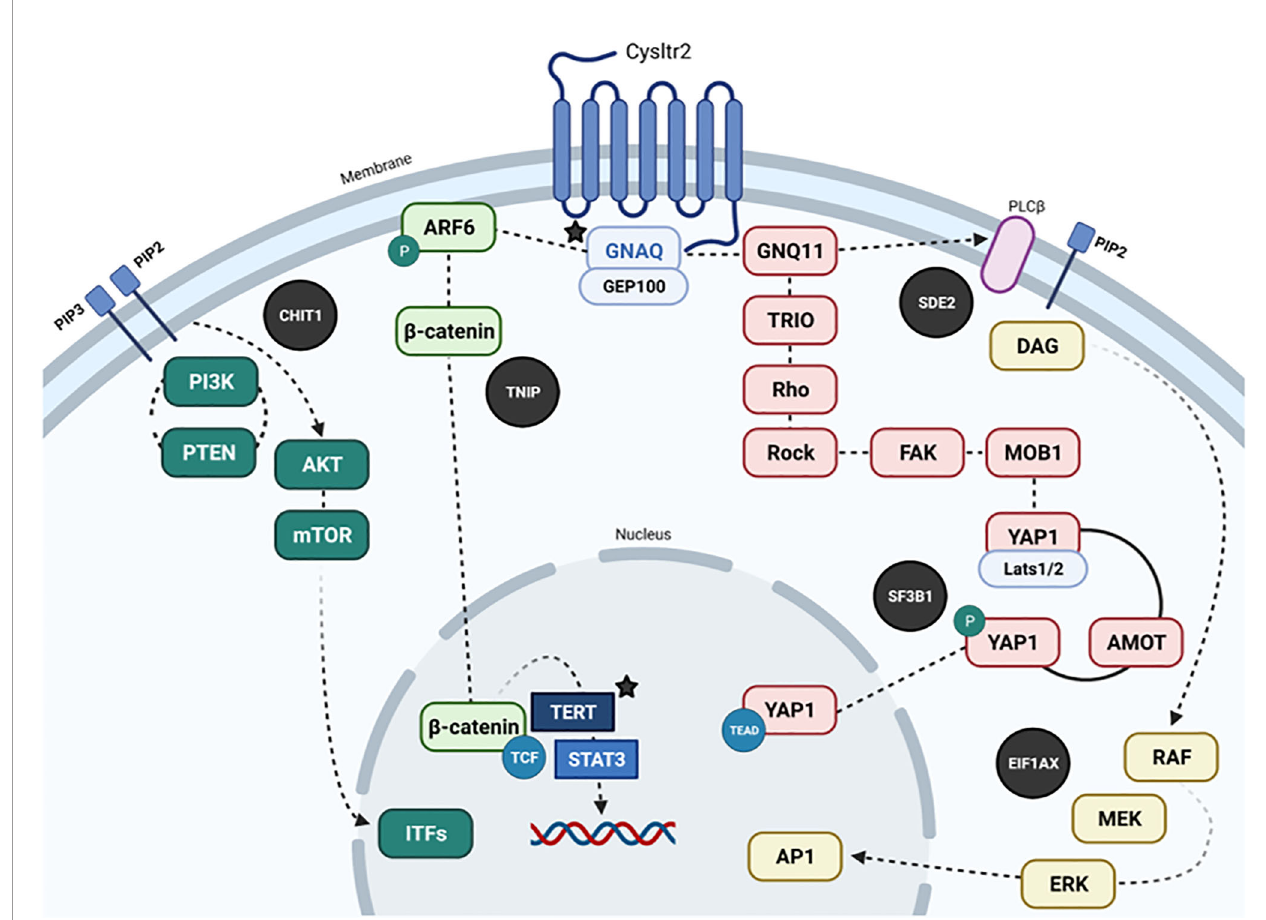
FIGURE 7 | Dysregulated pathways in PMMs (in black circles, other mutated genes are highlighted with their protein representation, and colocalization parallel to the main signaling pathways). Recurrent mutations in GNAQ, PLC b 4, and CYSLTR2 are mutually exclusive and trigger G a q signaling and related pathways (Akt/mTOR, Wnt/ b -catenin, Yes-associated protein (YAP), and MAPK pathways). In brief, GNAQ mediates signals between the G protein-coupled receptor (GPCR) and downstream effectors. Receptor activation by ligand binding causes the activation of GNAQ by catalyzing the release of GDP and binding of GTP. In its active form, GTP-bound GNAQ causes the release of the beta and gamma subunits of the heterotrimeric G-protein. GTP-GNAQ and beta and gamma subunits transfer the receptor-mediated signal to downstream effectors through secondary messengers, which participate in diverse signaling pathways to evoke different effectors. The known effectors for GNAQ include PLC beta, p63-RhoGEF, Trio, and Duet. GNAQ has been shown to activate the MAP kinase pathway, possibly via DAG-mediated activation of protein kinase C isoforms. GNAQ has an intrinsic GTPase domain at the C terminus, which causes the hydrolysis of GTP to GDP, and the G-alpha-GDP re-associates with G-beta and G-gamma subunits. Somatic mutations in GNAQ have been described in uveal and meningeal melanocytic neoplasias. In uveal melanoma, 97% of the hotspot mutations cause the amino acid substitution Q209L (data similar to rare cases originating in the meninges); the other 3% of mutations generate amino acid change R183Q. The Glutamine 209 of GNAQ is similar to residue 61 of RAS protein. The Q209 and R183 mutations cause a complete or partial loss of intrinsic GTPase activity, thereby locking the protein in a constitutively active form. Q209 and R183 mutations occur in a mutually exclusive pattern in human neoplasia. Mutations in GNAQ are also mutually exclusive from the hotspot mutations in GNA11, which belongs to the same family and shares 90% sequence homology. GNAQ mutations are not concurrent with other common oncogenic mutations in BRAF, NRAS, or KIT found in common melanomas. CYSLTR2, Cysteinyl leukotriene receptor 2; PIP3, Phosphatidylinositol, 3,4,5)-trisphosphate; PIP2, Phosphatidylinositol 4,5-bisphosphate; GNAQ, G protein subunit alpha q; ARF6, ADP-ribosylation factor 6; GNQ11, G protein subunit alpha 11; GEP100, ADP-Ribosylation Factor - Guanine nucleotide-Exchange Protein; PI3K, Phosphatidylinositol 3-kinase; PTEN, phosphatase and tensin homolog; AKT, AKT serine/threonine kinase; mTOR, mechanistic target of rapamycin kinase; CHIT1, Chitinase 1; TNIP, TNFAIP3 interacting protein; TRIO, Triple functional domain protein; Rho, Rho factor; Rock, Rho kinase; FAK, PTK2 protein; MOB1, MOB kinase 1A; YAP, Yes-associated protein 1; AMOT, Angiomotin; TERT, Telomerase reverse transcriptase; RAF, RAF kinase; MEK, Mitogen-activated protein kinase; ERK, extracellular signal-regulated kinase; STAT3, Signal transducer and activator of transcription 3; SF3B1, Splicing factor 3B subunit 1; EIF1AX, Eukaryotic translation initiation factor